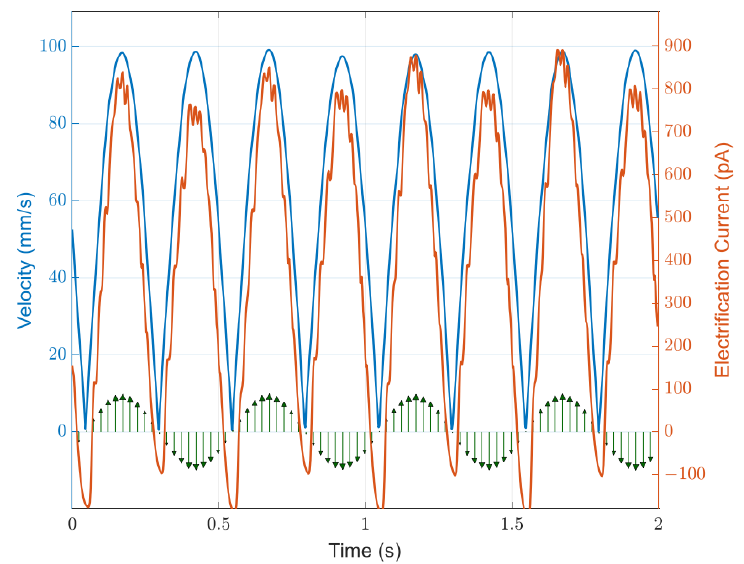
Figure 7. Intermittent shuttle velocity signal and generated electrification current. The top electrode swings with a frequency of 2 Hz. Black lines show the direction of electrode